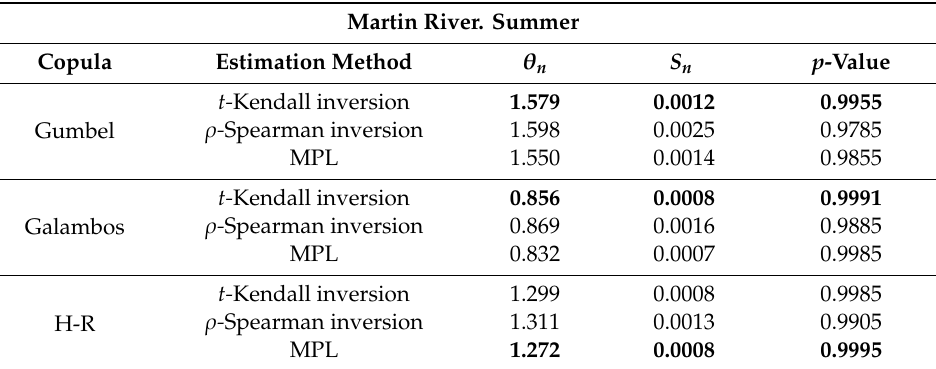
Table 8. Estimated copula values for di ff erent methods. Summer